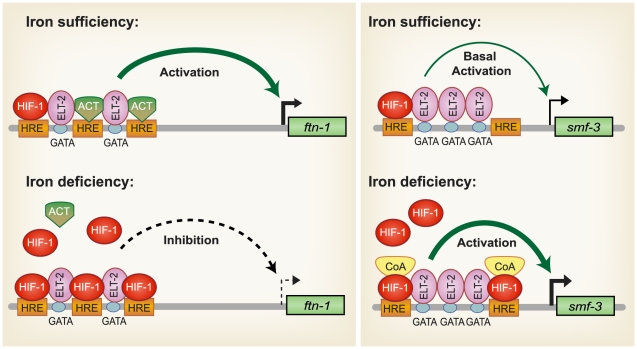
Model for HIF-1 iron-dependent activation and inhibition of intestinal iron uptake and storage.
Iron sufficiency: ELT-2 binds to GATA binding sites located in the ftn-1 and ftn-2 IDEs. We propose that ELT- 2 cooperates with an unidentified transcriptional activator (ACT) that binds to the HREs and enhances transcription. smf-3 is transcribed at basal levels during iron sufficiency. HIF-1 is expressed during normal growth conditions, but at low levels. Iron deficiency: HIF-1 is stabilized and dimerizes with AHA-1. HIF-1/AHA-1 (denoted by HIF-1) displaces the unidentified transcriptional activator binding to the ftn-1 and ftn-2 HREs and inhibits transcription. HIF-1/AHA-1 binds to the smf-3 HREs, recruits coactivators and cooperates with ELT-2 to enhance smf-3 transcription. Whether ELT-2 is bound to the ftn-1 GATA sites during iron deficiency and to the smf-3 GATA sites during iron sufficiency has not been determined.